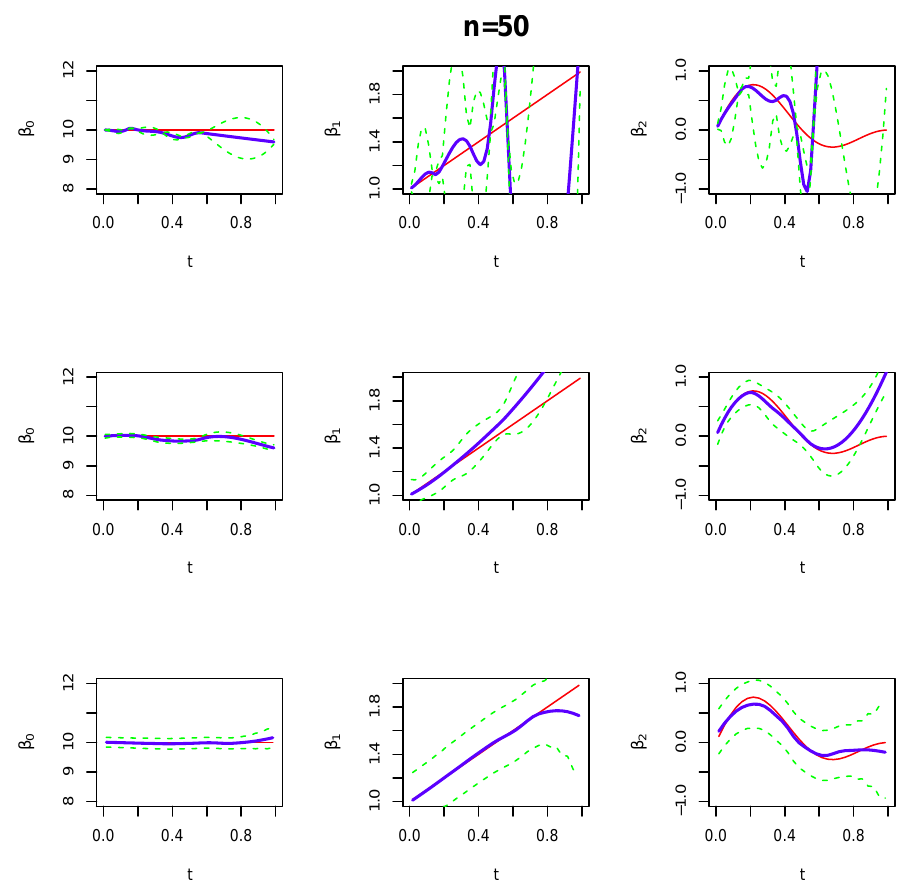
Figure 2. Performance of curve estimation when the sample size is 50 and the random seed is “set.seed(1)” in R. First row: curve estimation performance of the spline smoother; Second row: curve estimation performance of the local polynomial model; Third row: curve estimation performance of the proposed RKHS method. Solid red line: true curve; Solid blue line: estimated curve; Dotted lower and upper green lines: 95% confidence bands.